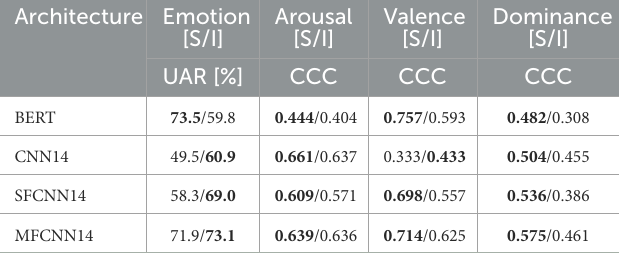
TABLE 5 UAR (%) and CCC results for the best performing dimensional and categorical emotion models on IEMOCAP. Architecture Emotion [S/I]